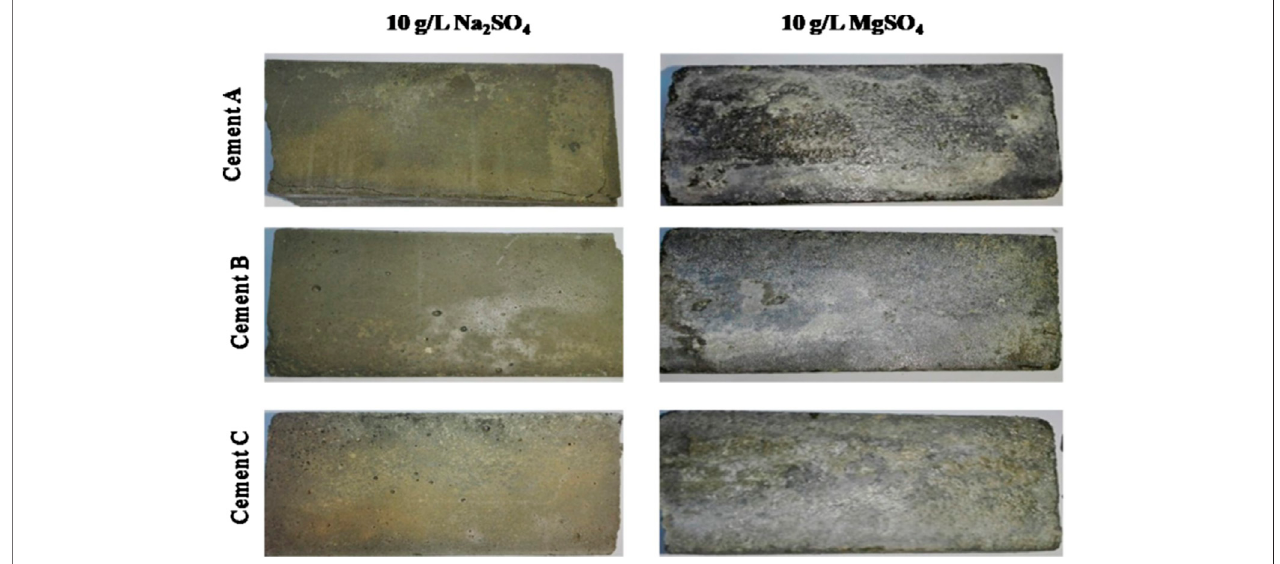
FIGURE 3 | Photograph of mortars of different samples of Tunisian sulfate-resisting Portland cement conserved for 2 years in 10 g/L Na 2 SO 4 and 10 g/L MgSO 4 (Labidi et al., 2019a).